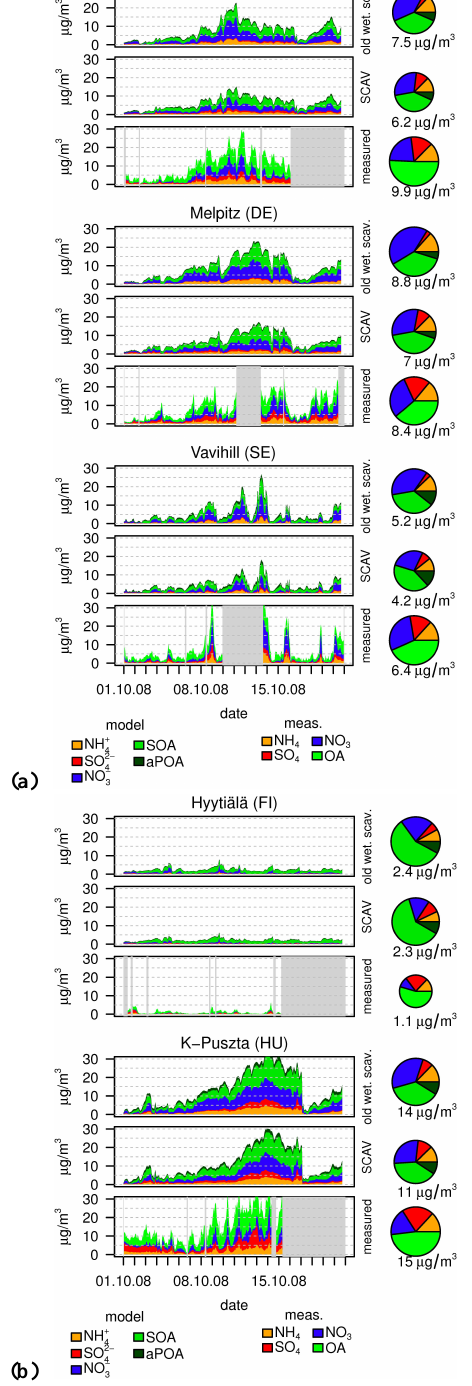
Fig. 6. (a) Timeline of chemical composition of non-refractory PM below 1µm (top: reference simulation, middle: simulation with SCAV, bottom: measured by AMS) during autumn 2008. Pie charts give mean over time period (size of pie relates total mass). Mea- sured OA should be compared with the sum of modeled aPOA + SOA. Gray shaded areas mask times without measurement data. (b) As (a) but for different stations.